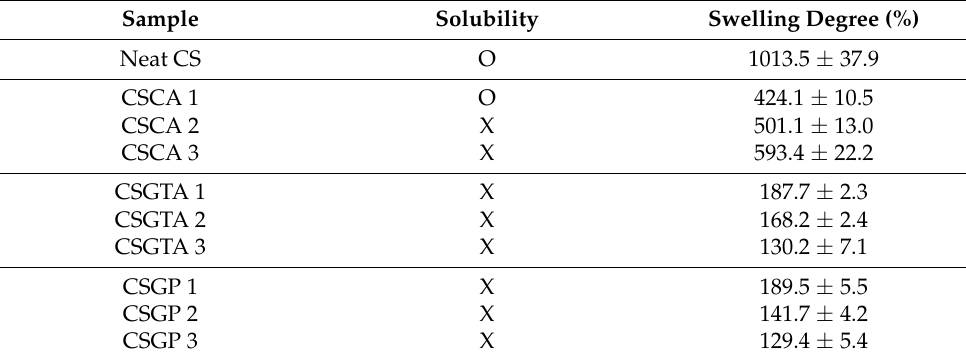
Figure 2. Solubility behavior images of the crosslinked CS films with various crosslinker concentrations under an acidic condition (pH 2.6). Undissolved CS films in aqueous 1.0% acetic acid solution (pH 2.6) immersed for 24 h were marked by red circles. Table 2. The results of the solubility and swelling tests under different pH conditions (CSCA 1/2/3 for CS:CA = 1:500/750/1000, CSGTA 1/2/3 for CS:GTA = 1:50/100/200, and CSGP 1/2/3 for CS:GP = 1:25/50/100 in their respective crosslinking